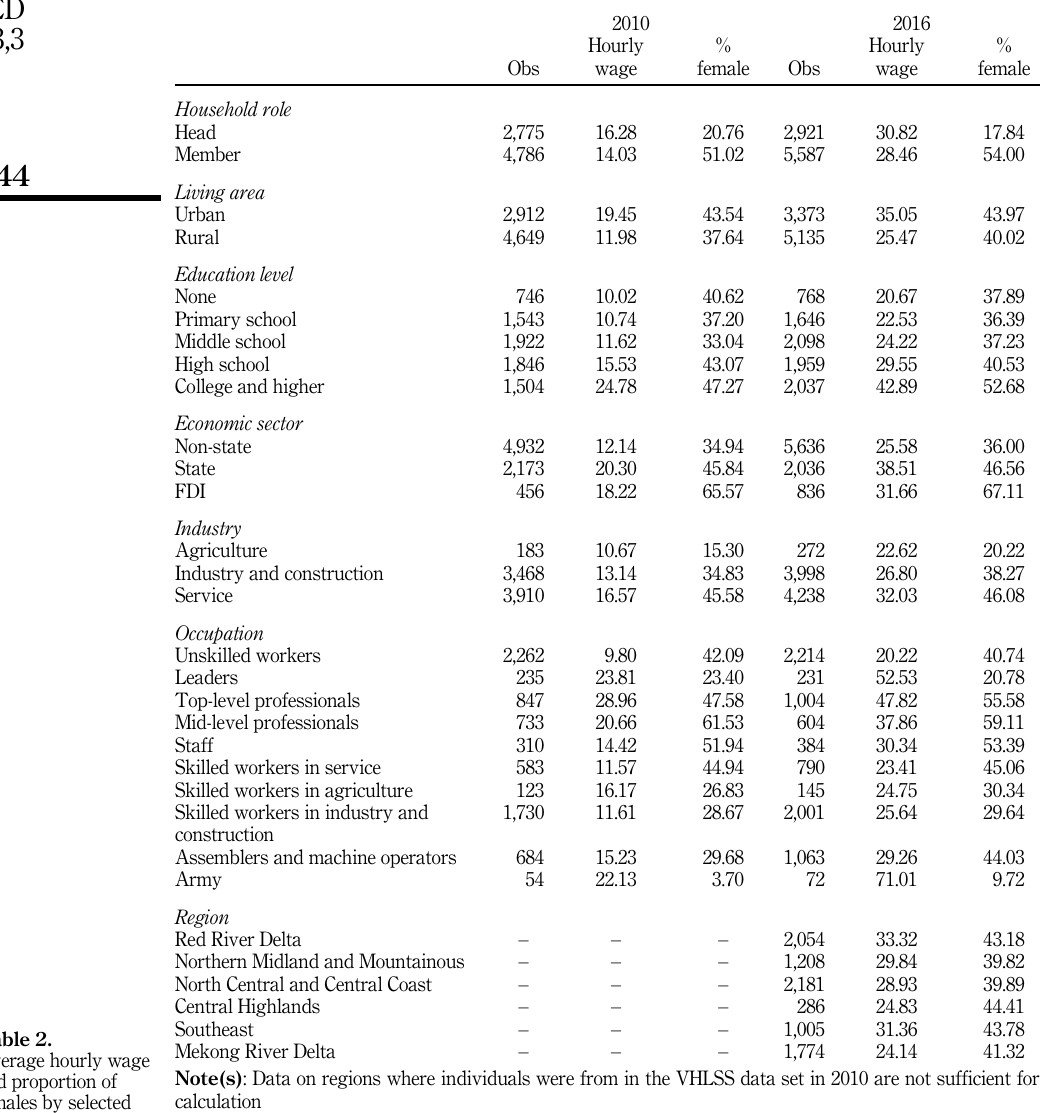
Table 2. Average hourly wage and proportion of females by selected